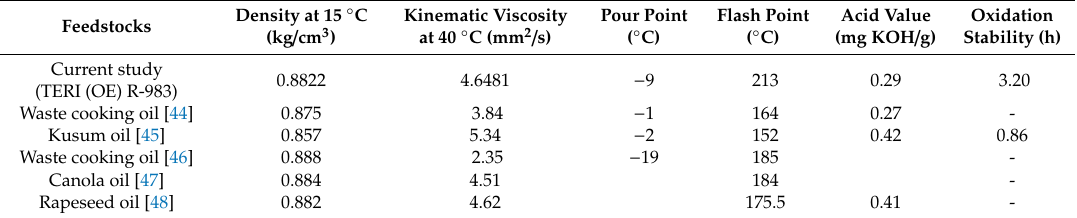
Table 7. Comparison of the properties of TERI (OE) R-983 biodiesel with biodiesels made from other